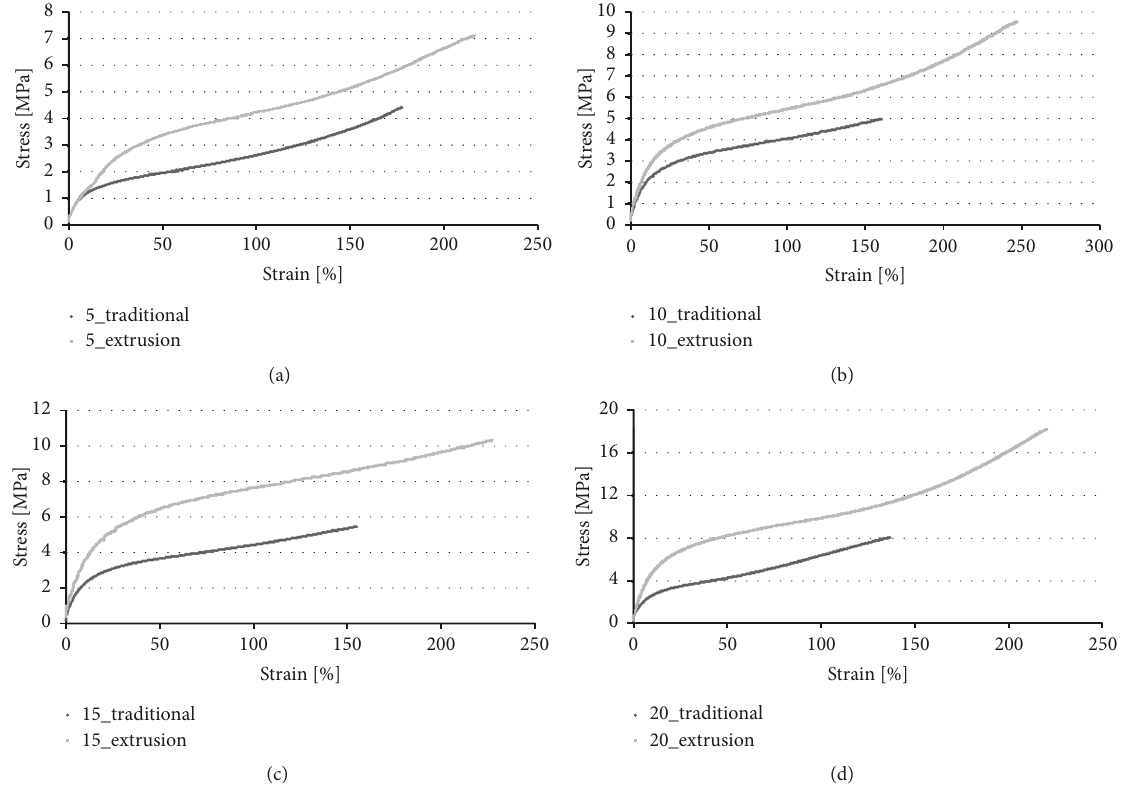
Figure 2: Stress-strain plots of composites filled with 5 phr (a), 10 phr (b), 15 phr (c), 20 phr, and (d) carbon black prepared using extrusion and traditional rubber processing methods.